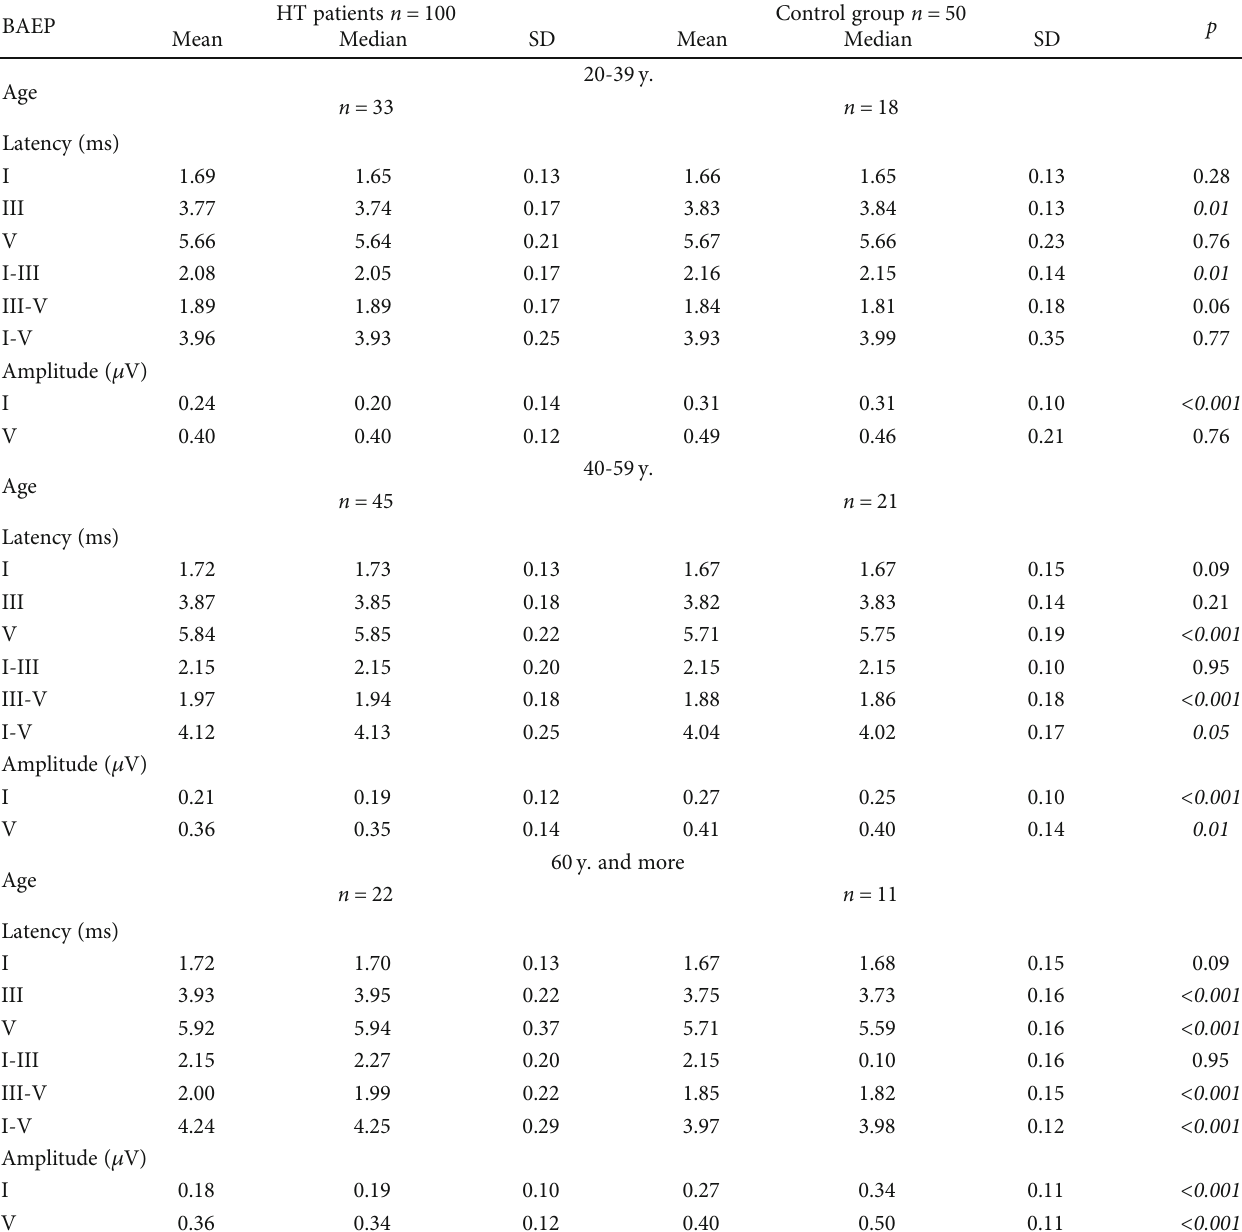
Table 6: Mean values of the latency (ms) and amplitude ( μ V) of BAEP parameters in HT patients and in the control group according to age. HT patients n = BAEP